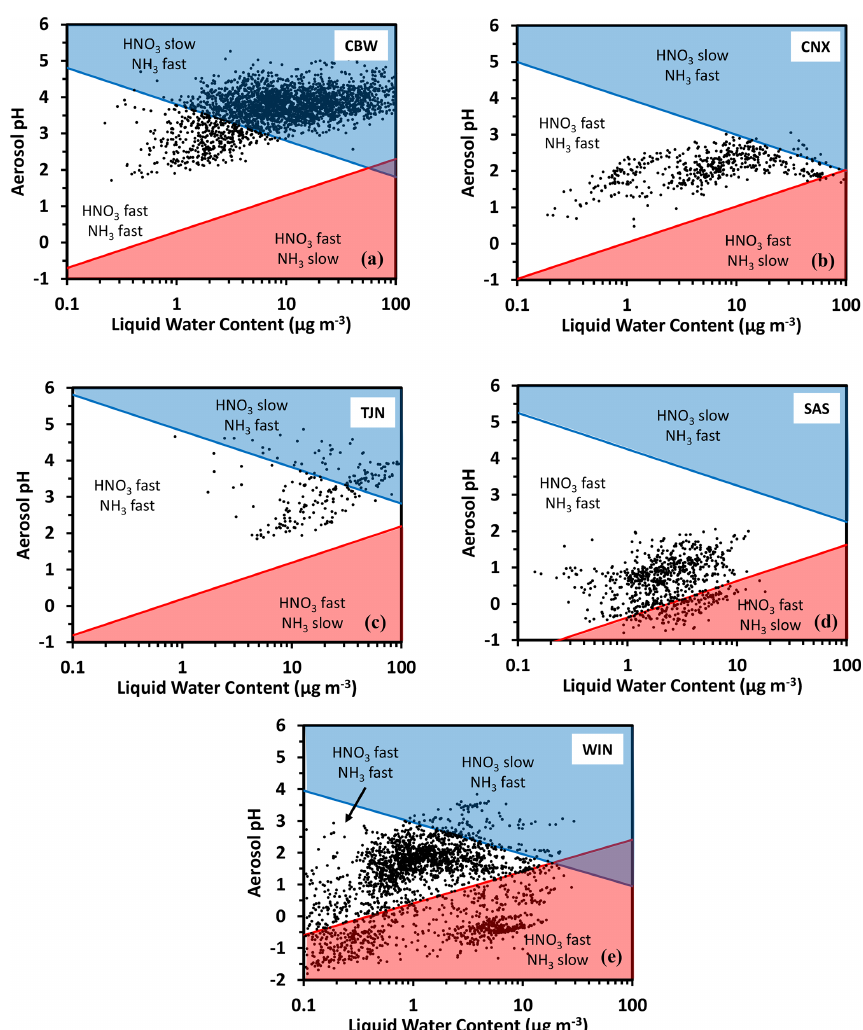
Figure 3. Domains of reactive nitrogen deposition for five regions examined: (a) Cabauw – CBW, (b) CalNex – CNX, (c) Tianjin – TJN, (d) SE United States – SAS, and (e) NE United States